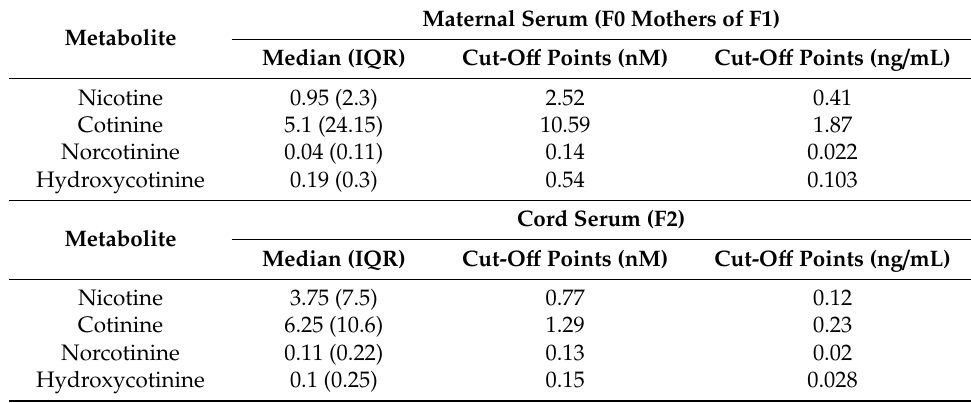
Table 3. Cut-o ff points for nicotine and its metabolites in maternal (F0 mothers of F1 generation) and cord sera (F2 generation) based on the lowest cluster from cluster-analysis.